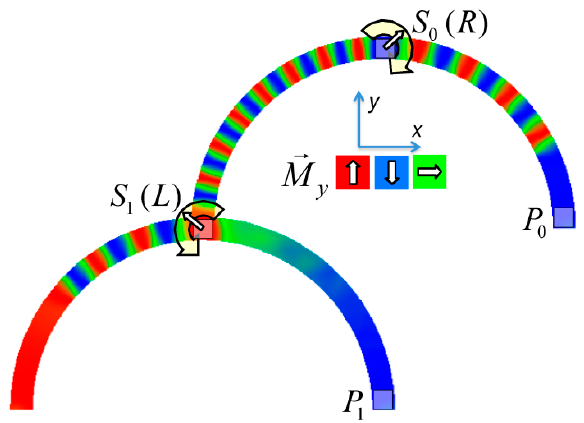
Figure 7. Example of double-curve system with two inputs S i and two outputs P i .